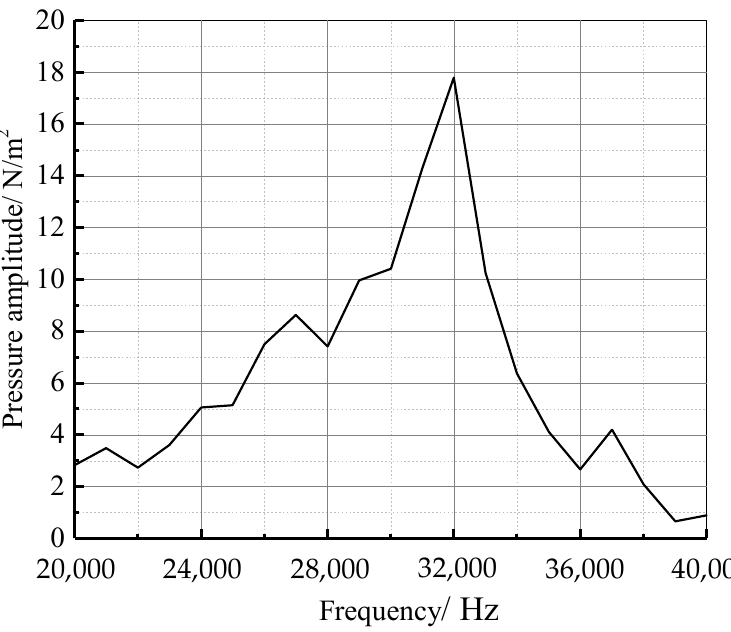
Figure 9. Sound pressure frequency spectrum curves of the equivalent sound source.